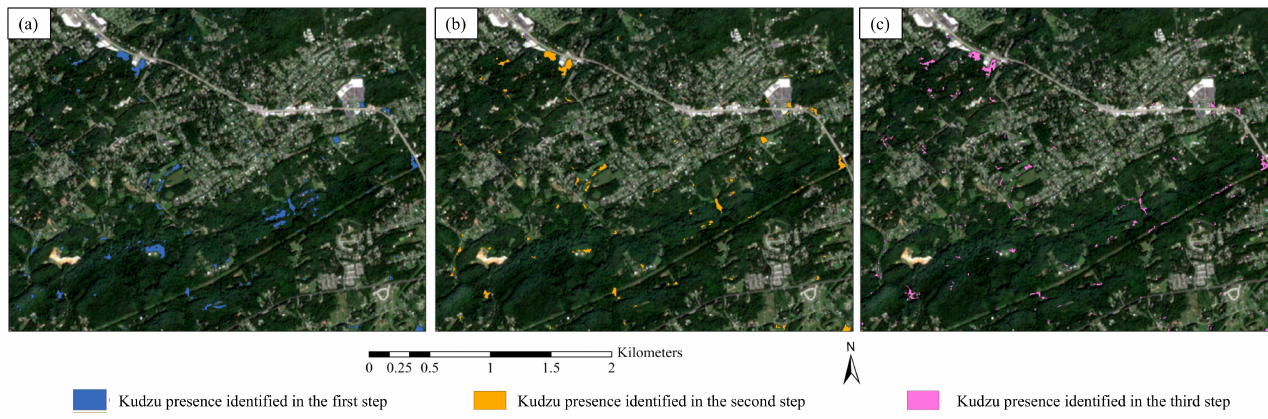
Figure 9. An example of kudzu invasion in Knox County. The background image is Sentinel-2 image acquired on 6 September 2020: ( a ) initial kudzu presence map from step 1; ( b ) potential kudzu presence map from step 2; ( c ) refined kudzu presence map from step